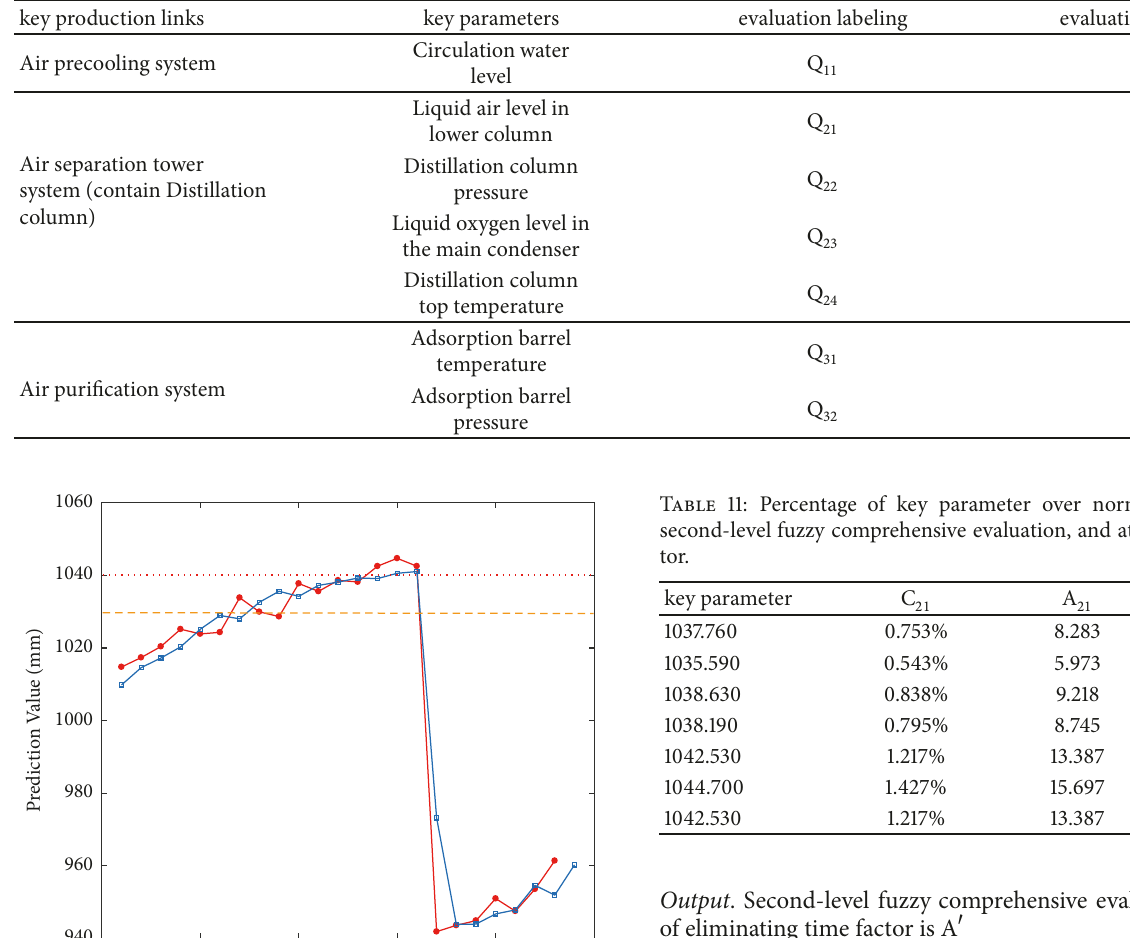
Table 10: Second-level fuzzy evaluation index and evaluation coefficient.